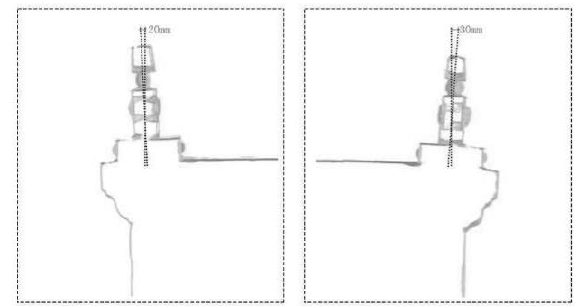
Figure. 4. Part of southwest and southeast stony frieze panel.